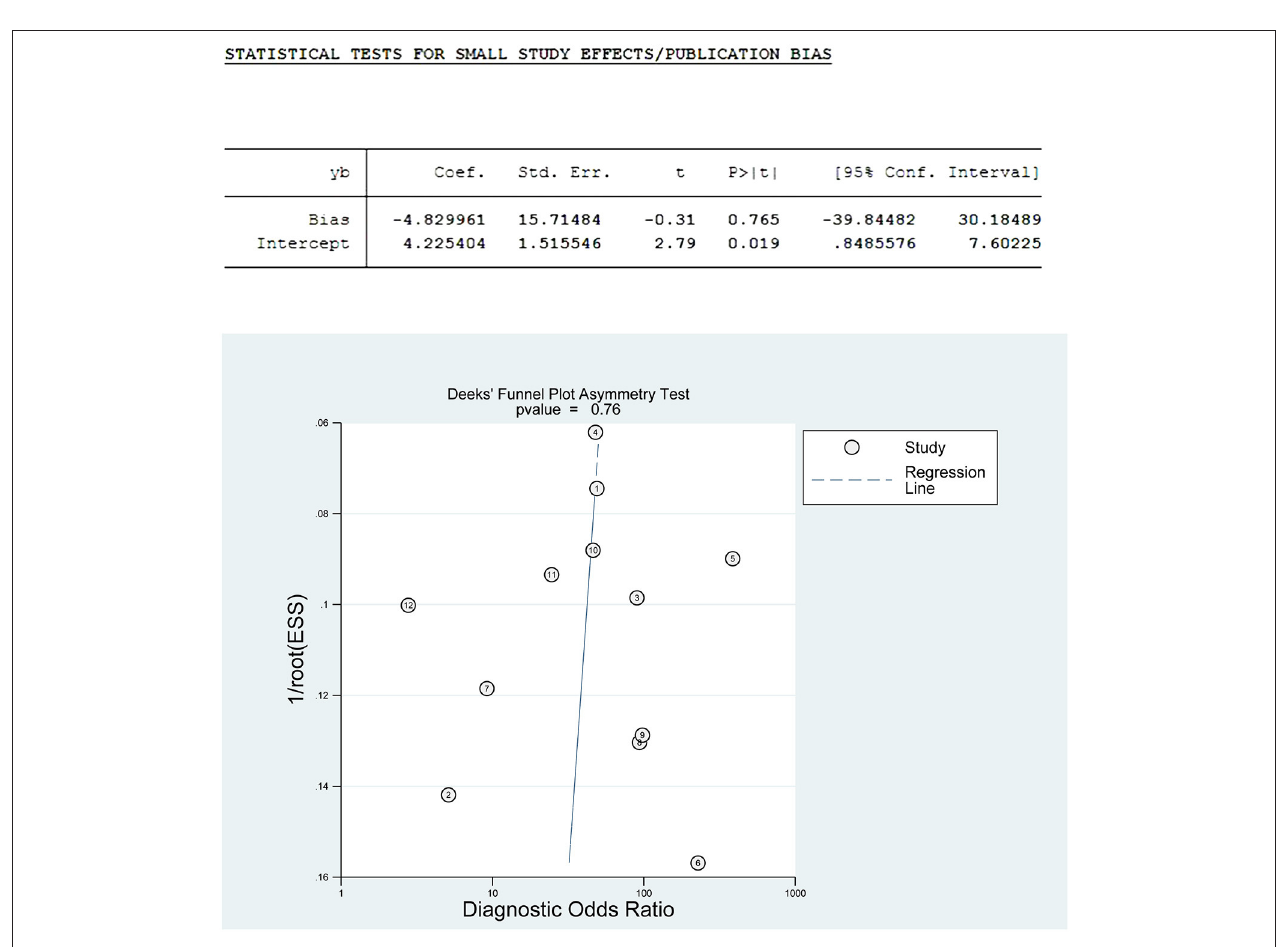
FIGURE 7 | Deeks’ funnel